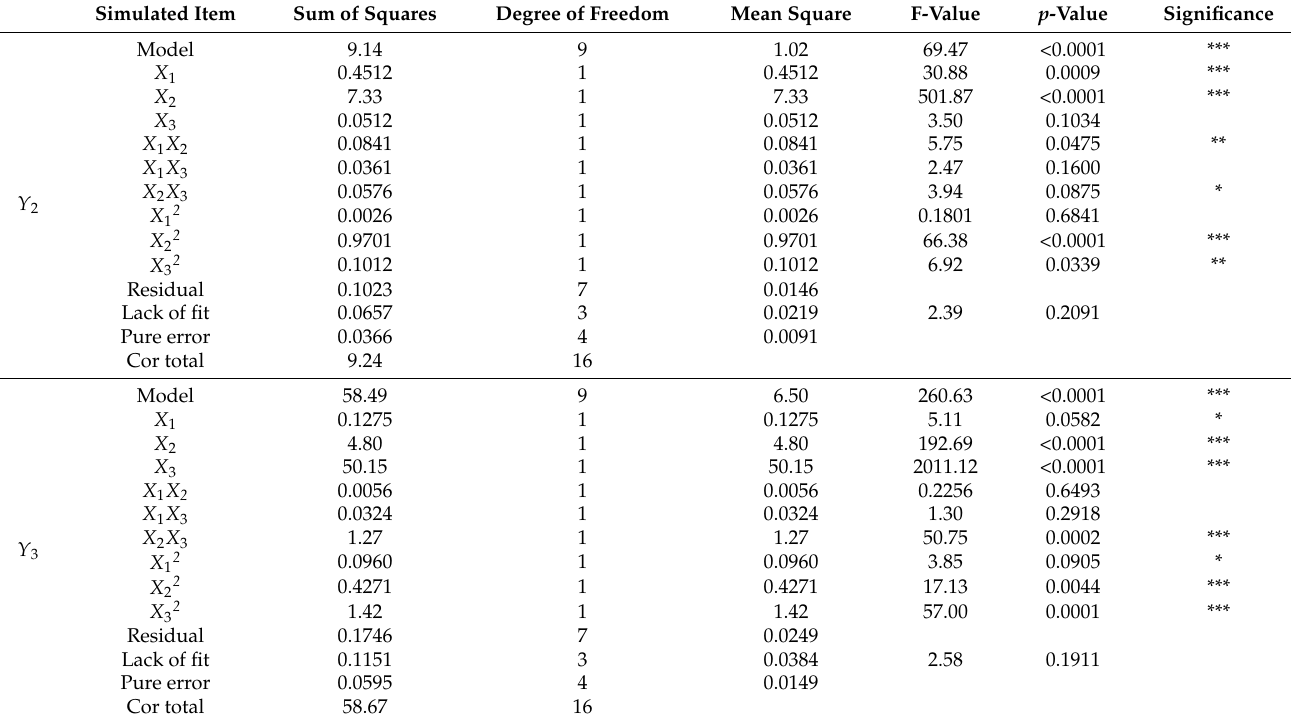
Establishment of the regression equation and significance analysis of the pickup rate